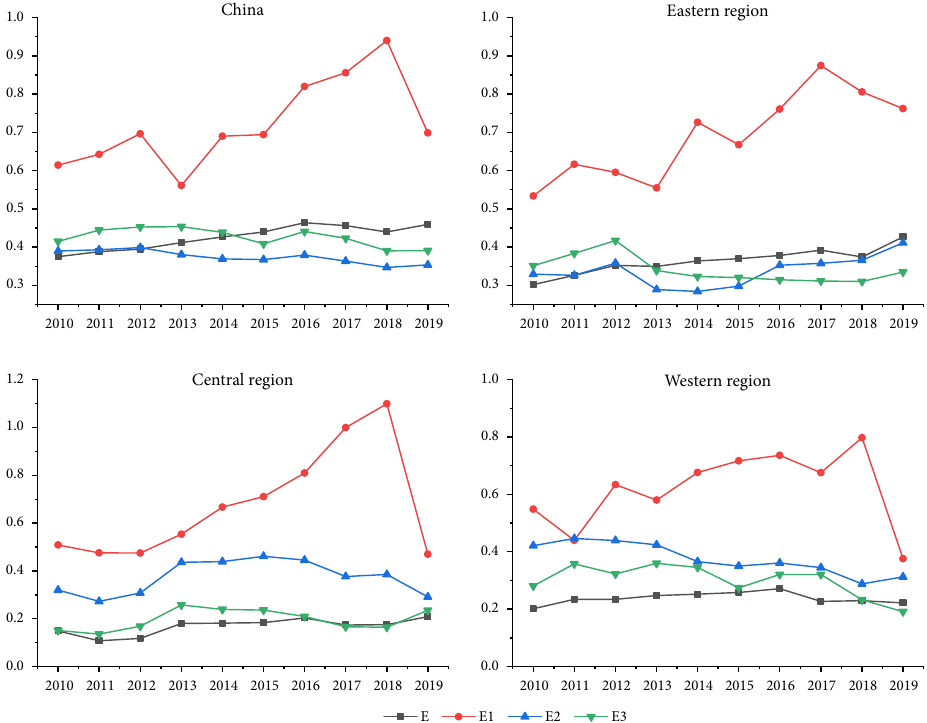
Figure 3. The CV of environemtnal